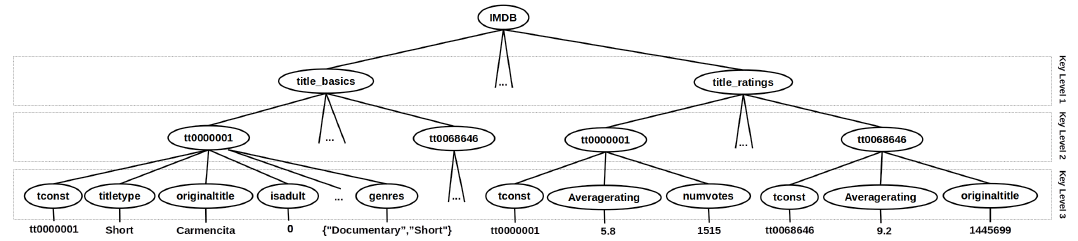
Figure 7. IMDb represented in the SQLToKeyNoSQL canonical model.